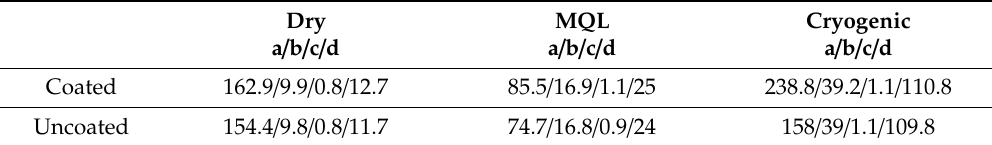
Table 4. Values for a ff ected layer constants in varying lubro / cooling and coating